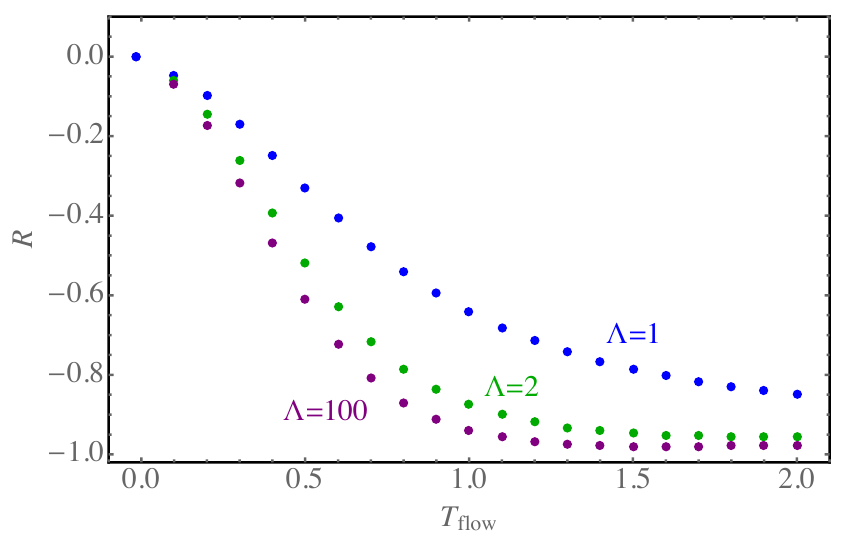
Figure 5 . T (cid:13)ow -dependence of the reweighting factor at various (cid:3)’s for the Gaussian model for p = 2, (cid:11) = 2, and (cid:12) = 3 (Case